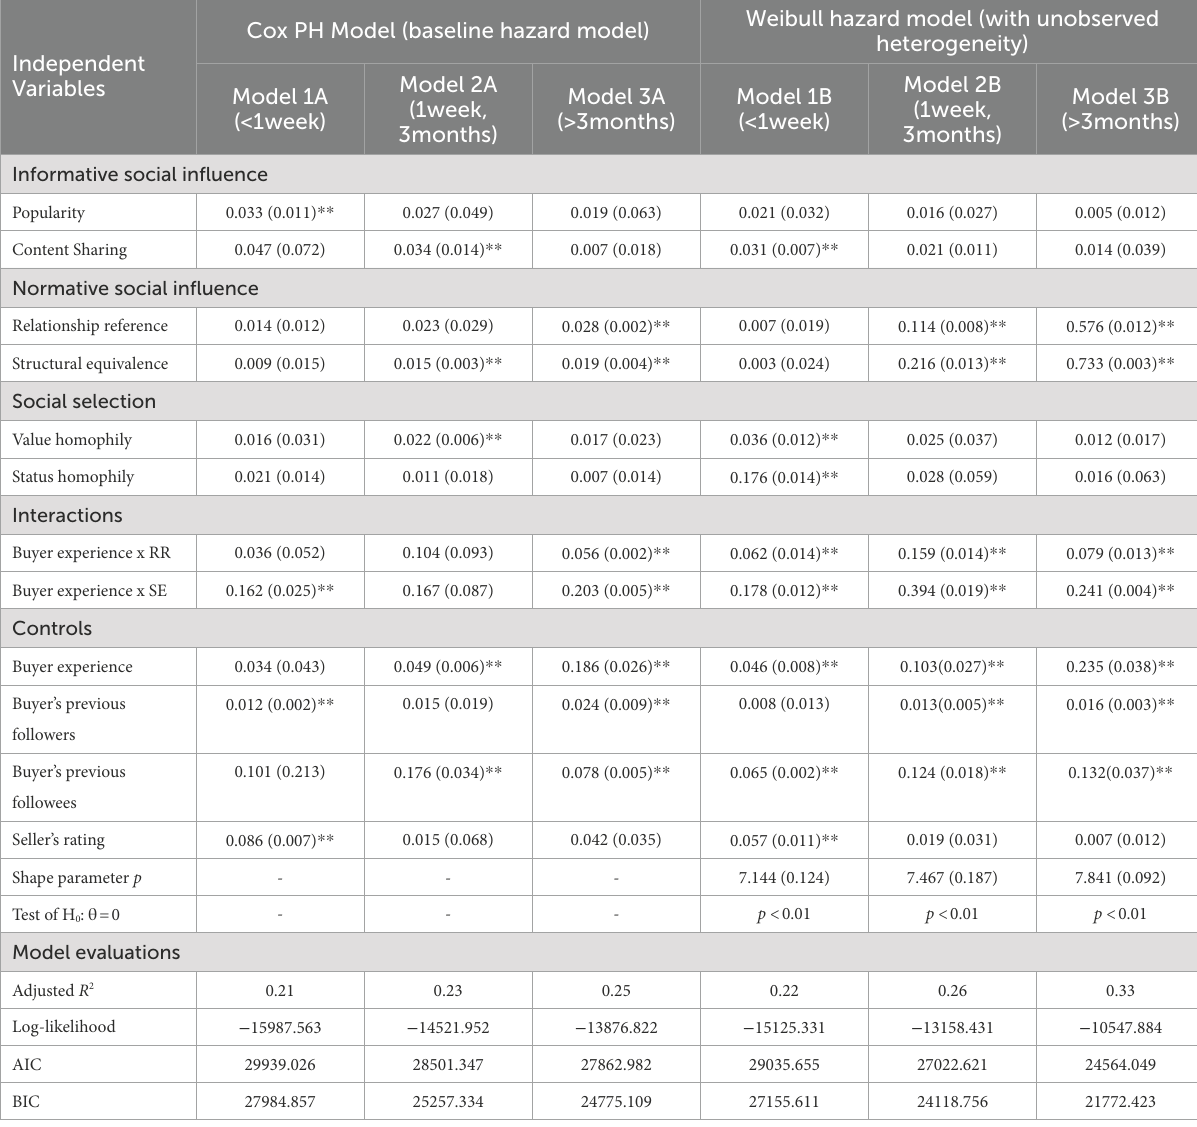
TABLE 4 Ties persistence model estimation and